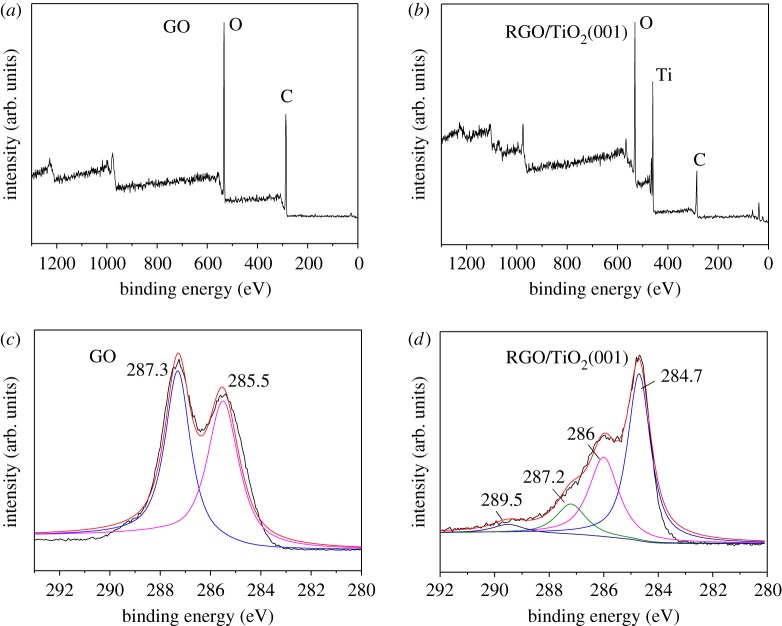
XPS spectra. Survey scans of GO (a) and RGO/TiO2 (001) (b). High-resolution spectra of C1s of GO (c) and RGO/TiO2 (001) (d).